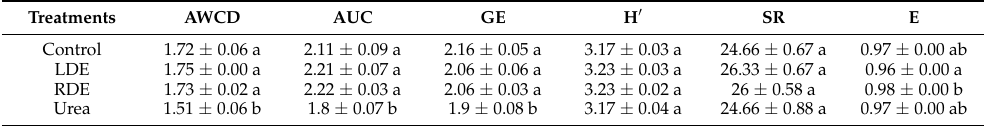
Table 3. Substrate average color development (AWCD), the area under the curve (AUC), growth efficiency (GE), Shannon diversity index (H (cid:48) ), substrate richness (SR), and Shannon’s evenness (E) of the soil bacterial community of fescue pots after incubation for 96 h in Biolog EcoPlates with the application of RDE or LDE, urea, and non-amended control (mean n = 3 ± S.E). Different letters beside the numbers of each column indicate significant differences at p < 0.05.